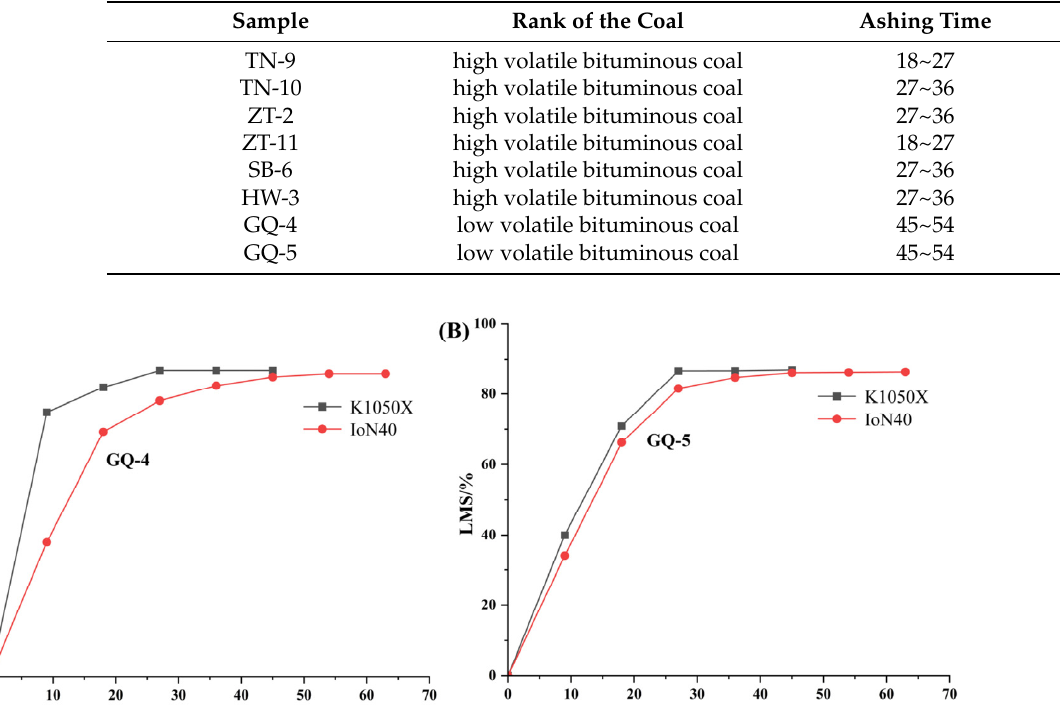
Table 7. The rank of the coal samples and their ashing time (h) in program B.